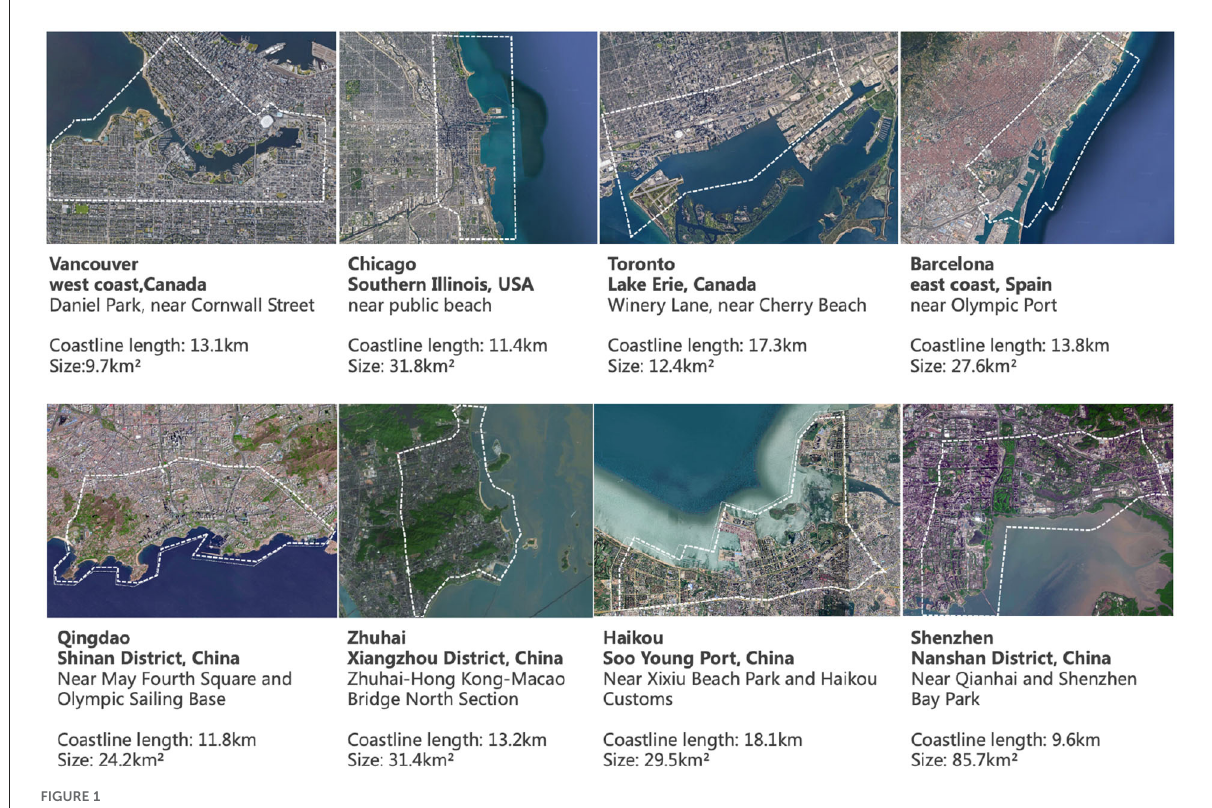
FIGURE1 Site conditions of the eight selected coastal zone